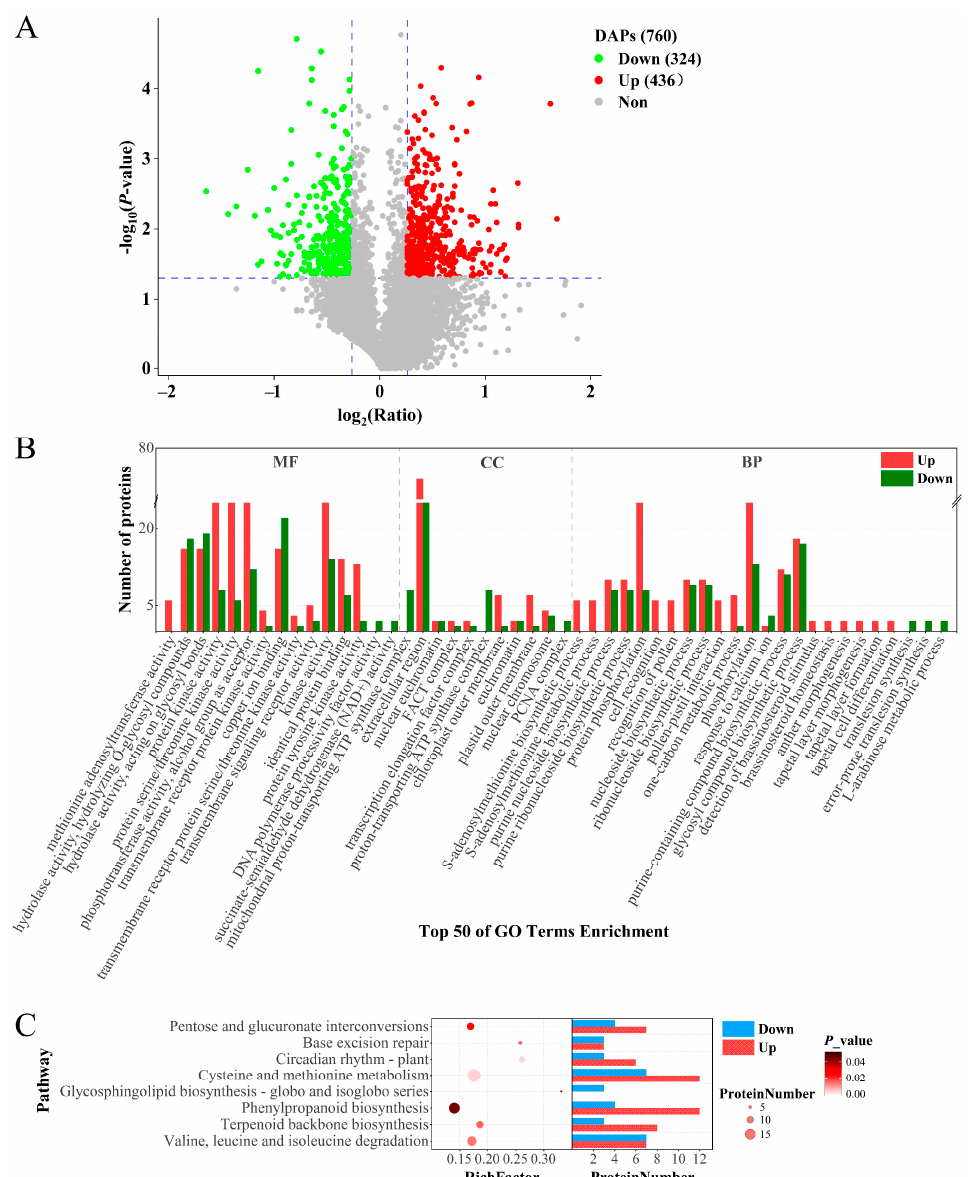
Figure 4. Analysis of differentially abundant proteins (DAPs) in floral buds of inap CMS line compared with its maintainer line H3. ( A ) Volcano plot of DAPs between inap CMS vs. H3. ( B ) The top 50 GO Terms with significant enrichment of DAPs. Red and green bars represent up- and downregulated proteins in inap CMS, respectively. MF, molecular function. CC, cellular component. BP, biological process. ( C ) KEGG significant enrichment analysis of DAPs. Red and blue bars represent up- and downregulated proteins in inap CMS, respectively.